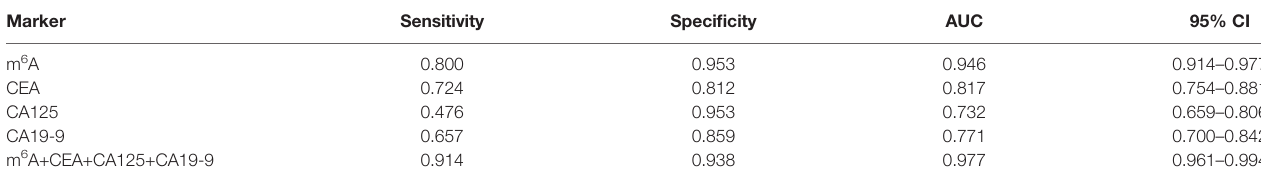
TABLE 2 | Sensitivity and speci fi city of the diagnostic value of various markers alone and in combination. Marker